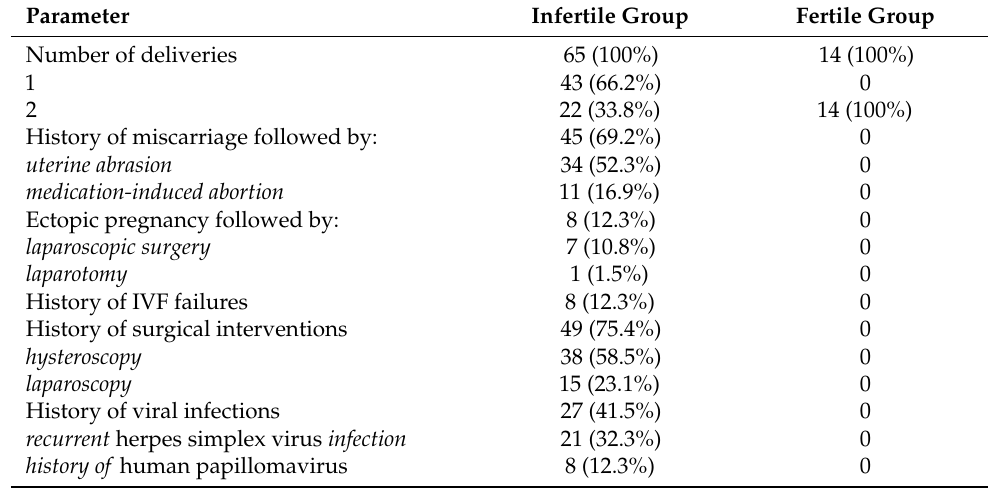
Table 6. Parameters of obstetric and gynecological history in the investigated